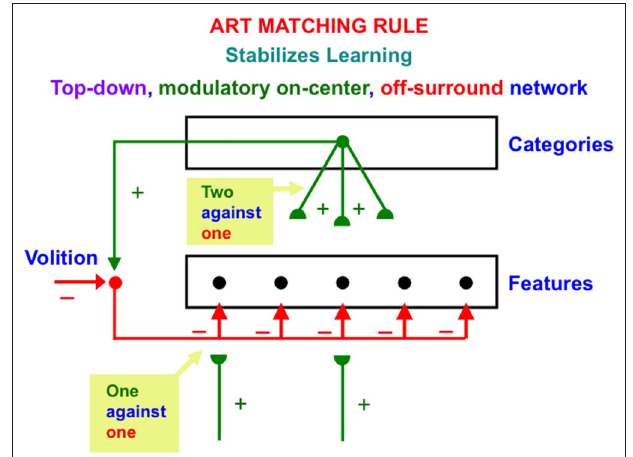
FIGURE 2 | The ART Matching Rule circuit enables bottom-up inputs to fire their target cells, top-down expectations to provide excitatory modulation of cells in their on-center while inhibiting cells in their off-surround, and a convergence of bottom-up and top-down signals to generate an attentional focus at matched cells while continuing to inhibit unmatched cells in the off-surround [adapted with permission from Grossberg (2017b)].